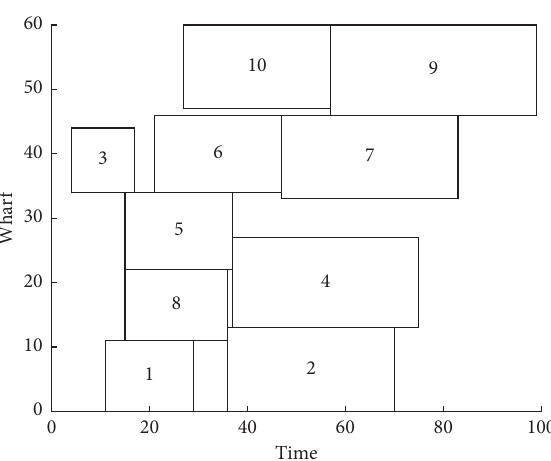
3: The right-justified berth plan of the example